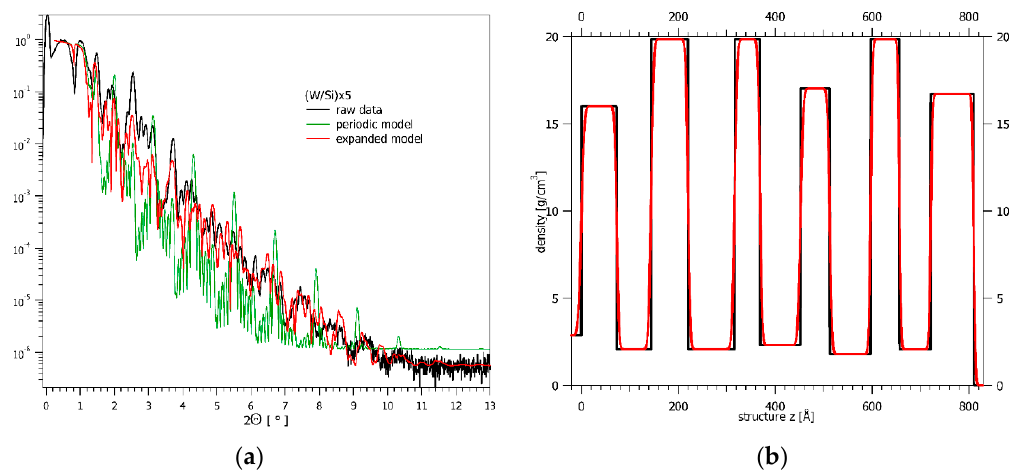
Figure 9. ( a ) Spectra and ( b ) density profile of XRR model of 5× W/Si multilayer.